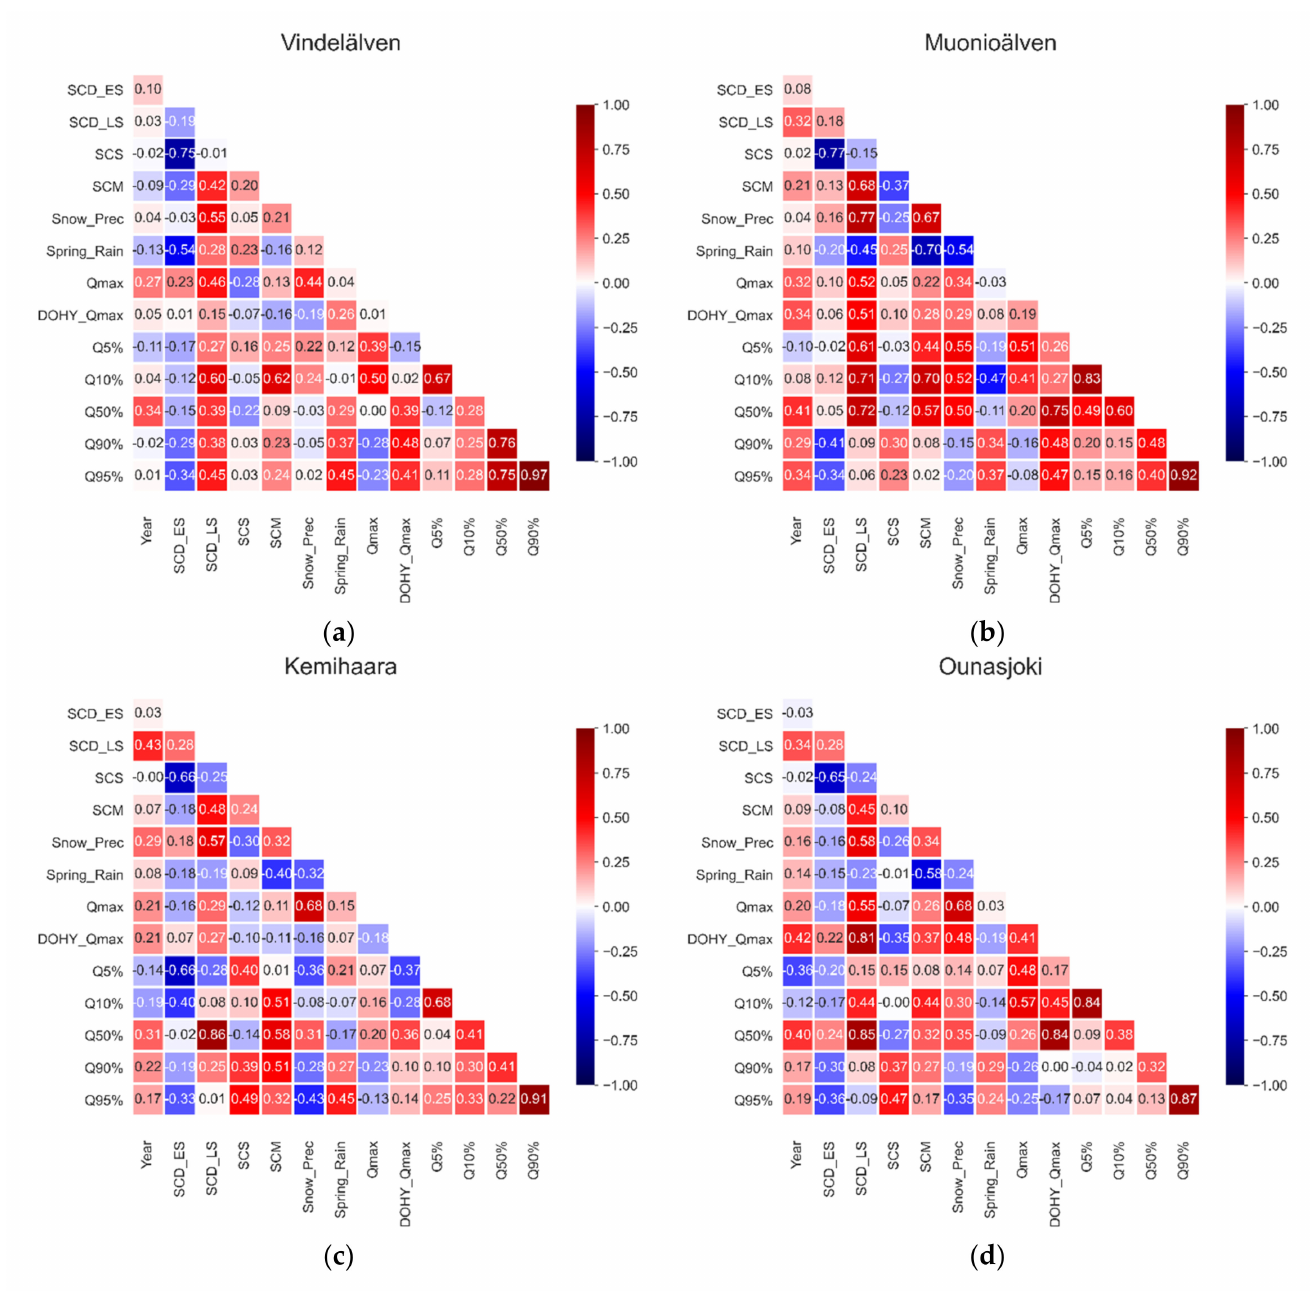
Figure 13. Correlation matrices for the timing measures of ( a ) Vindelälven, ( b ) Mounioälven, ( c ) Kemihaara, and ( d )